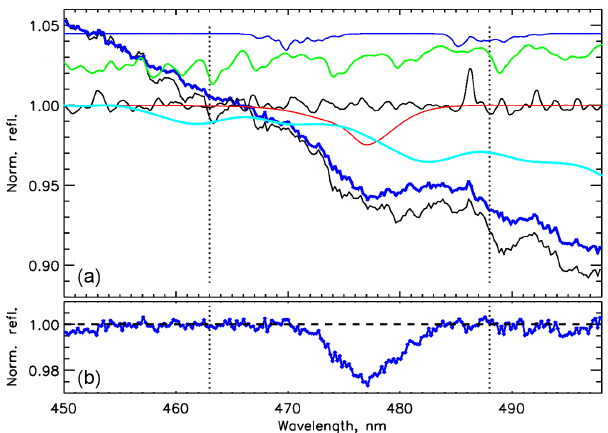
Figure 5. Similar to Fig. 4 but for the Sahara desert (OMI or- bit 8013, 16 January 2006, row 20, orbital exposure 1180). Panel (b) shows the rectified O 2 -O 2 absorption profile, i.e., the ratio of the data denoted by the red and blue lines in (a) , with additional adjustments to the blue-line data – see text for more